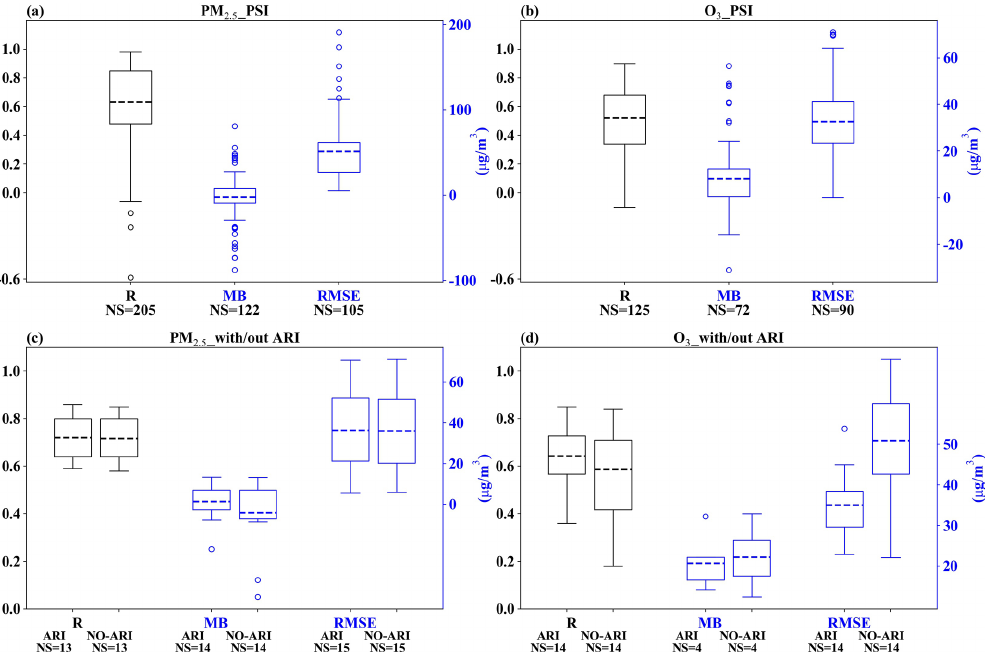
Figure 5. Quantile distributions of statistical indices for simulated PM 2 . 5 and O 3 (a, b) by the five two-way coupled models (WRF-Chem, WRF-CMAQ, GRAPES-CUACE, WRF-NAQPMS, and GATOR-GCMOM) and comparisons of statistical indices with and without ARI (c, d) in Asia.